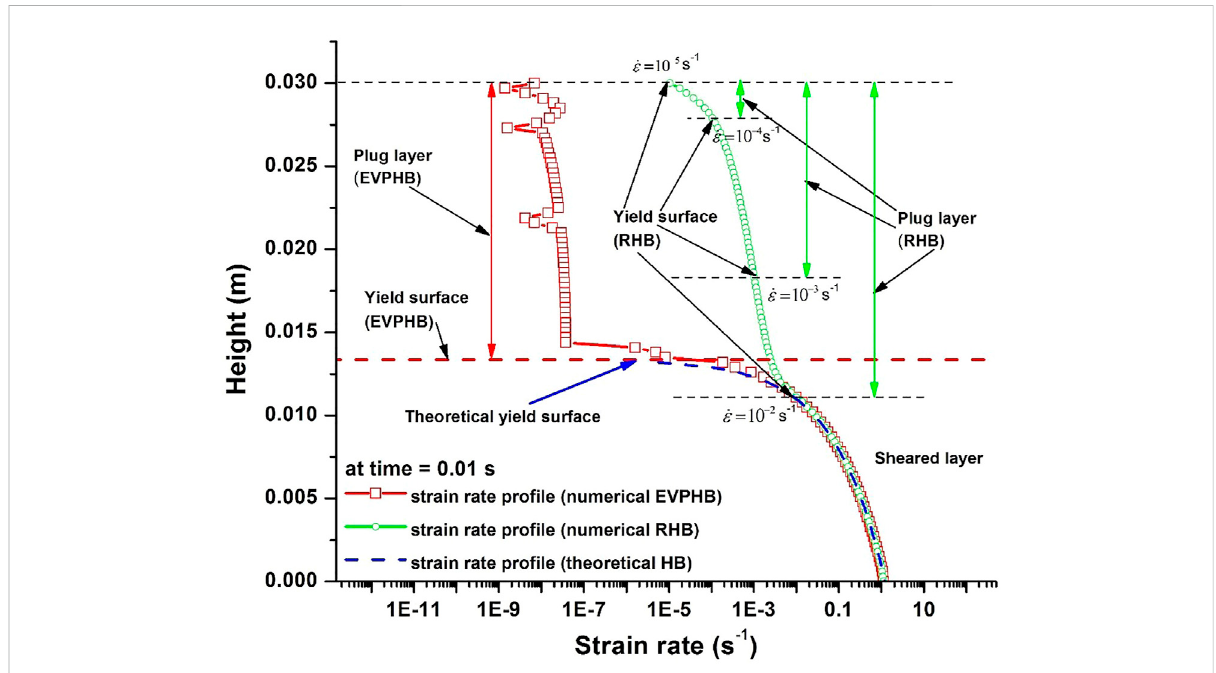
FIGURE 7 Yield surface determined with EVPHB and RHB models. For RHB model, the apparent yield surface corresponding to different strain rate threshold are indicated.